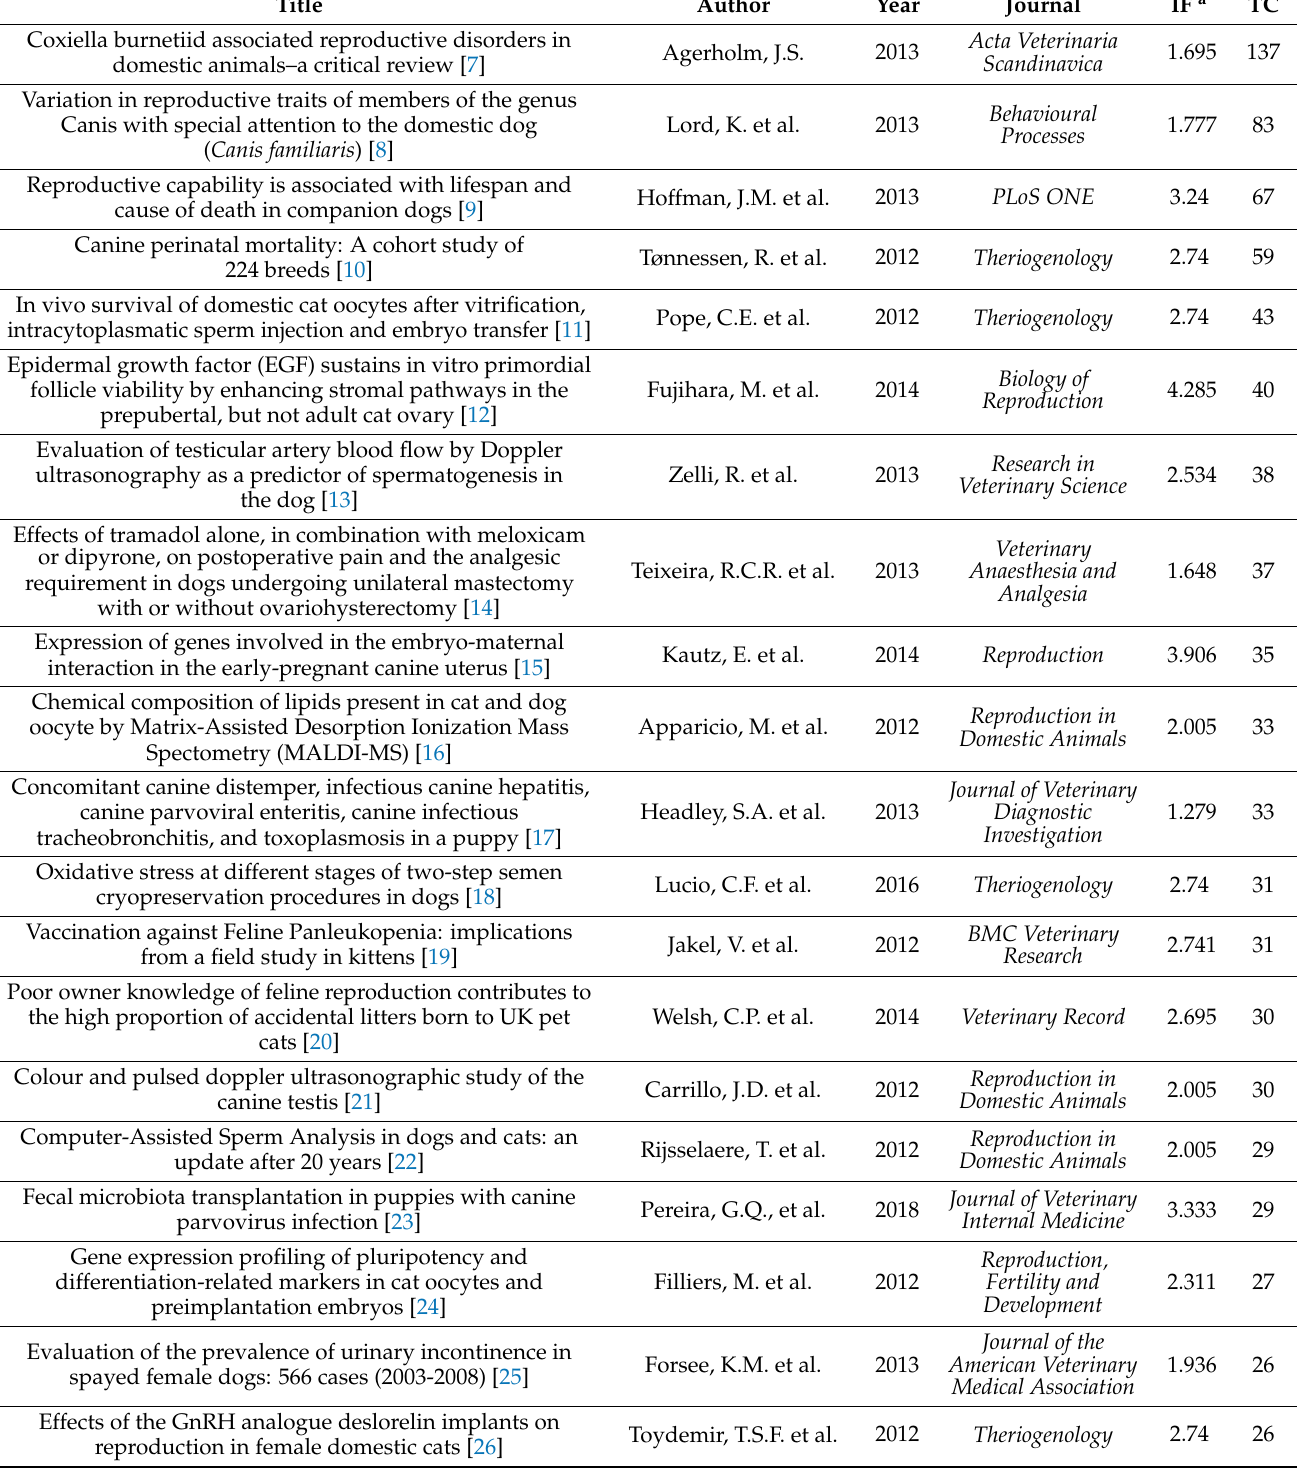
Table 3. The top twenty most-cited articles in the field of small animal